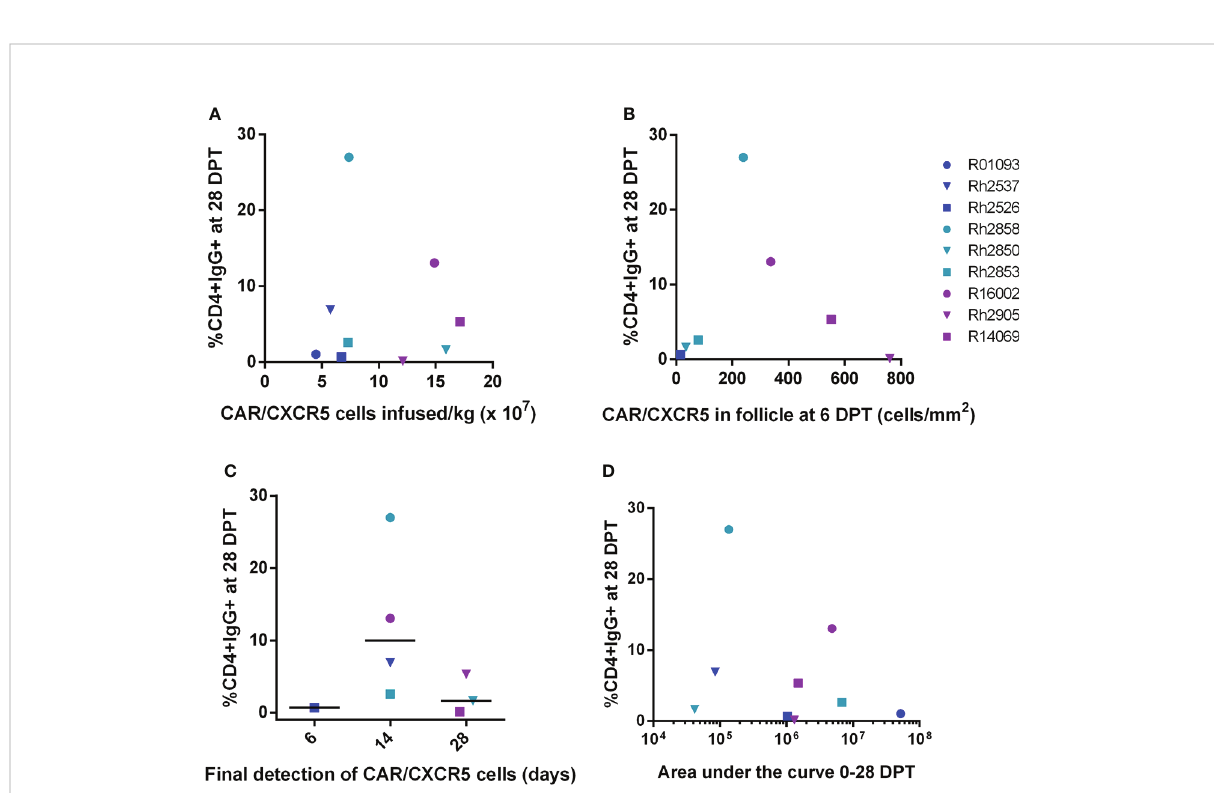
FIGURE 5 Anti-CAR antibody response at day 28 post-treatment versus the number of CD4-MBL CAR/CXCR5 cells infused/kg, peak level of CD4-MBL CAR/CXCR5 cells in B cell follicles, CD4-MBL CAR/CXCR5 persistence and viral load area under the curve. (A) Comparison of the level of IgG +CD4+ cells at 28 DPT and the number of MBL+CXCR5+ cells infused per kilogram (N = 9). (B) Comparison of the level of IgG+CD4+ cells at 28 DPT and number of CAR cells/mm 2 in the follicle at peak (6DPT) (N = 7). No data is available for R01093 or Rh2537. (C) Relationship of IgG +CD4+ cells at 28 DPT and the last time point that CD4-MBL CAR/CXCR5 T cells were detected in the B cell follicles (N = 8). The persistence of CD4-MBL CAR/CXCR5 cells was de fi ned as the last time point where CD4-MBL CAR/CXCR5 cells are detected in lymph node tissue at discrete biopsy time points. No data is available for R01093. Bars are drawn at the median. (D) Relationship of IgG+CD4+ cells at 28 DPT and the viral load area under the curve (AUC) from 0 to 28 DPT. All data were analyzed as a Spearman correlation. Data is presented for T1 (blue), T2 (teal), T3 (purple) and control (red)